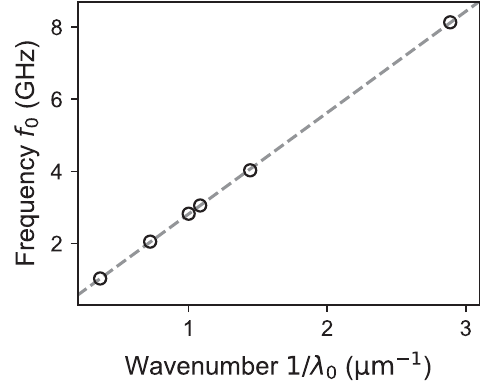
FIG. 8. Detection bandwidth. Pass band of a regular IDT with N ¼ 1 . 5 . The shaded area indicates the FWHM of the transmission peak. The vertical double-headed arrow indicates the employed resonance frequency of the detector IDT, f 0 ≈ 2 . 81